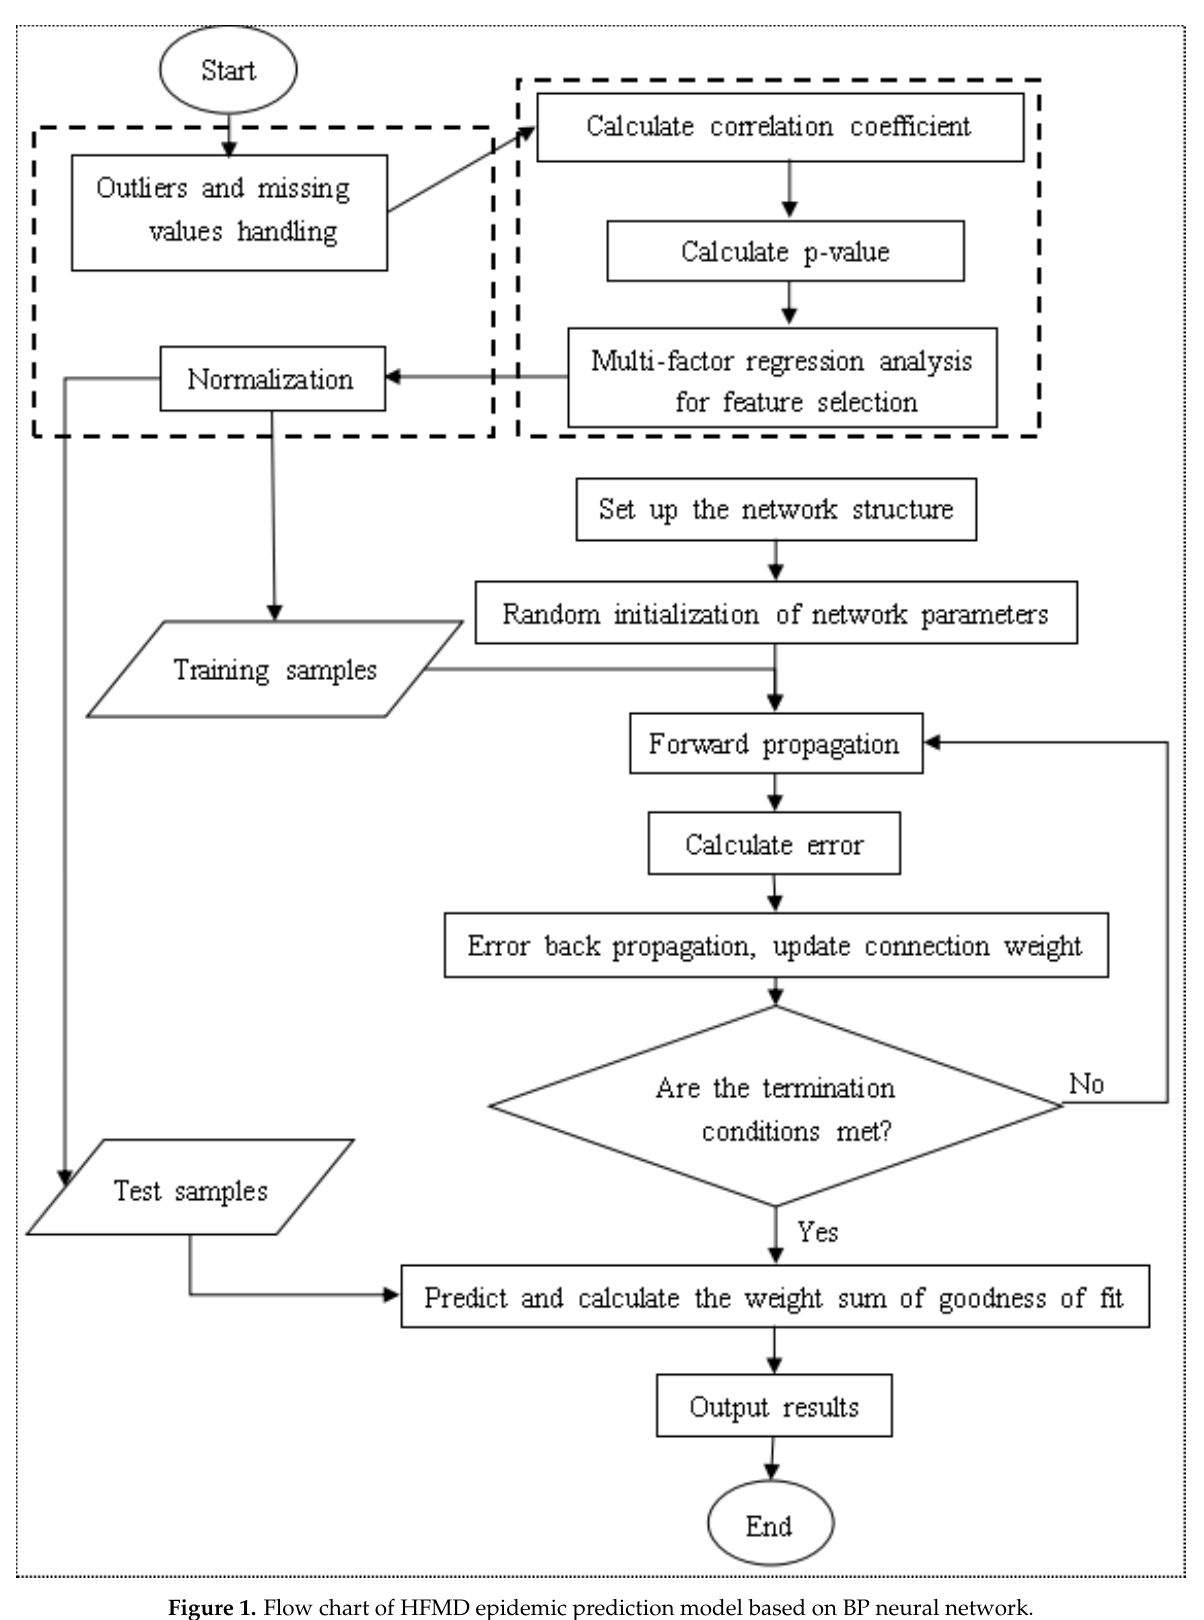
Figure 1. Flow chart of HFMD epidemic prediction model based on BP neural